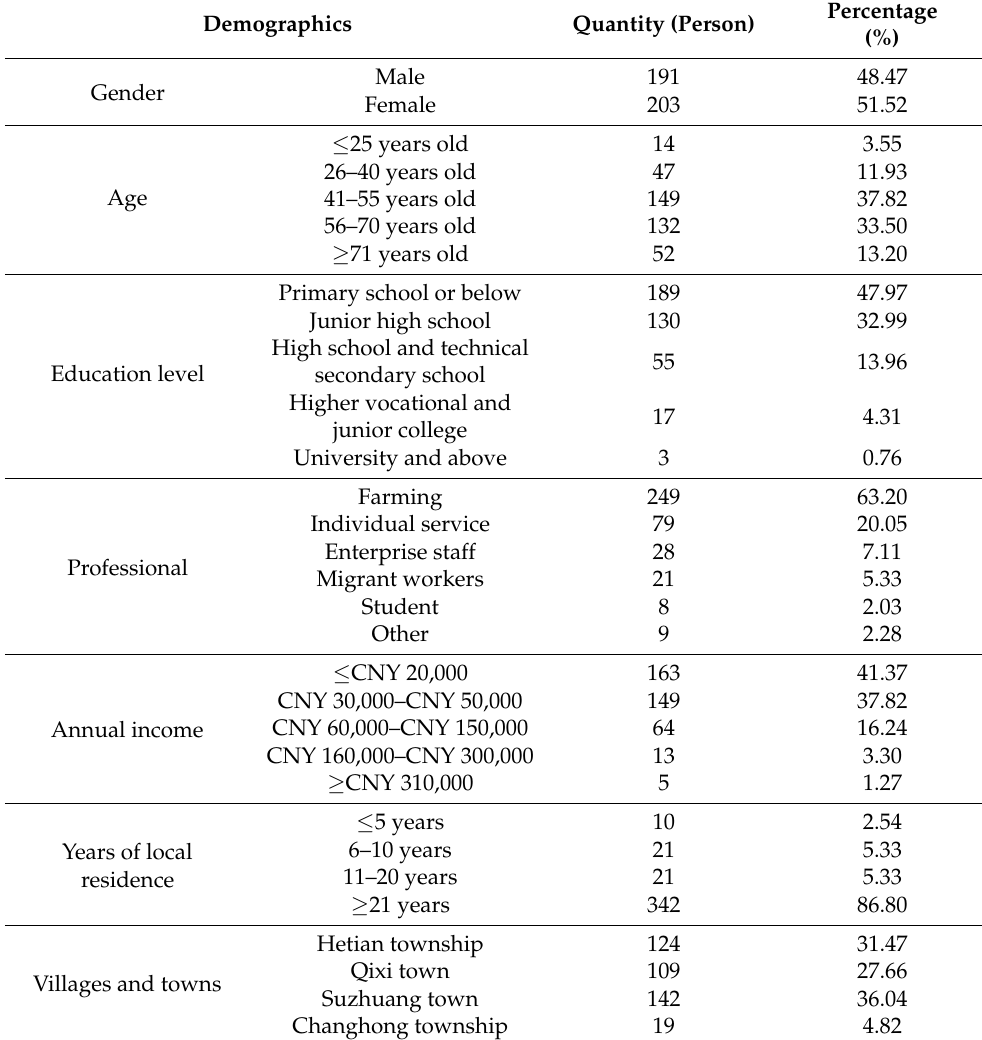
Table 1. Demographics of residents